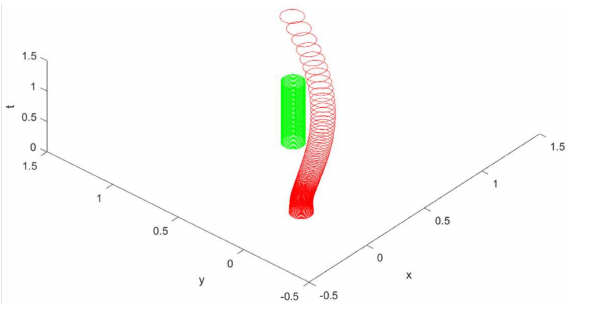
Figure 2. Elliptical tubes of trajectories for the E c [ t ] with regard for the obstacle constraint. The comparison diagram of the terminal ellipse and the target ellipse without obstacle